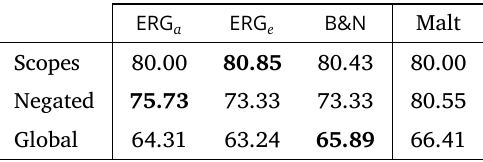
Performance of the negation resolution system on the development set with gold